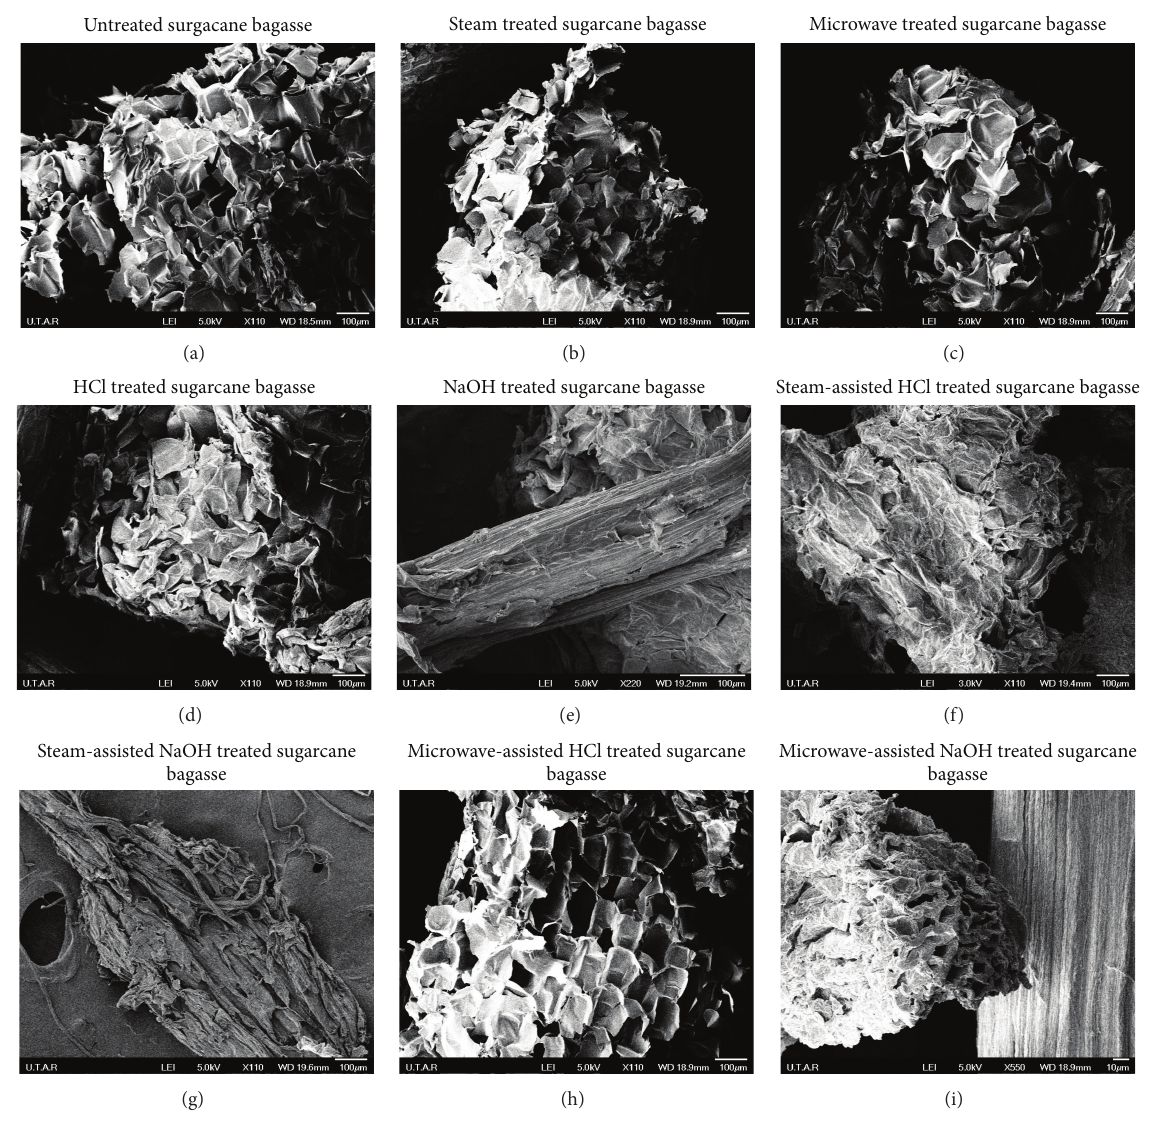
Figure 3: SEM images of sugarcane bagasse. (a) Untreated, (b) steam, (c) microwave, (d) HCl, (e) NaOH, (f) steam-assisted HCl, (g) steam- assisted NaOH, (h) microwave-assisted HCl, (i) and microwave-assisted NaOH.